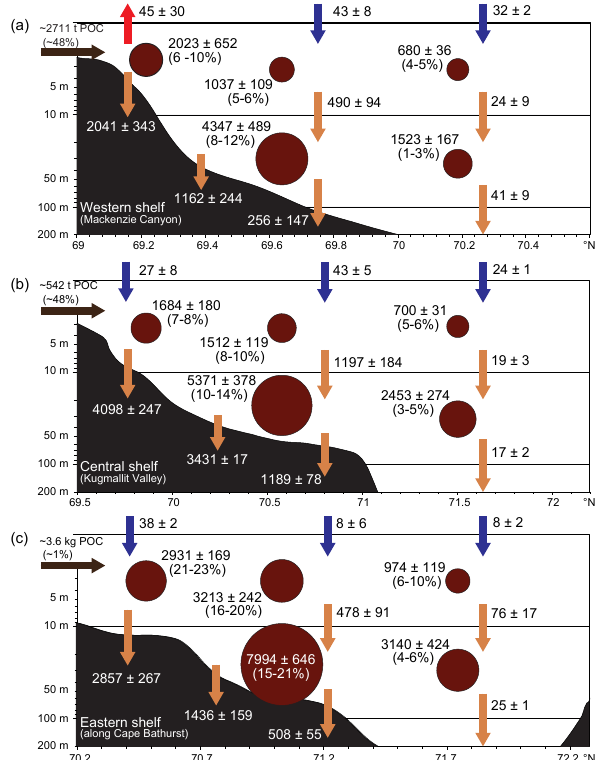
Figure 5. Cross-shelf averages (mean ± 0.95 confidence interval) of particulate organic carbon (POC) inventories (dark brown cir- cles), vertical POC fluxes (light brown arrows), riverine POC inputs (black arrows), and sea-to-air CO 2 fluxes (red and dark blue ar- rows). All pool units (circles) are in mgCm − 2 and all flux units (arrows) are inmgCm − 2 d − 1 , except the riverine inputs (which are in tons or kg per day). The percentage in brackets associated with every POC inventory and river input is the fraction of POC in total organic carbon (particulate + dissolved) that each value represents. The western, central and eastern regions correspond to the areas de- limited by 136–141 ◦ W, 131–136 ◦ W and 126–131 ◦ W, respectively (Fig. 1). For a detailed description on how each variable has been estimated, please see Sect. 2.4.